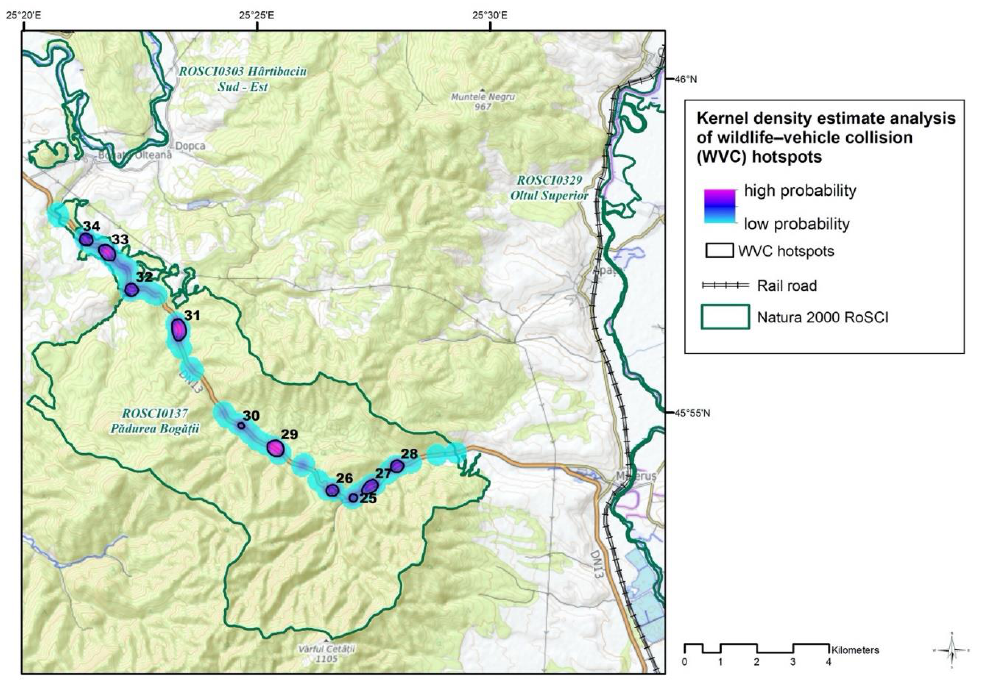
Figure 4. Model-based estimation of collision risk for Predeal – Rasnov (DN73A). High probability is represented in purple, and the WVC hotspot is dark circled.